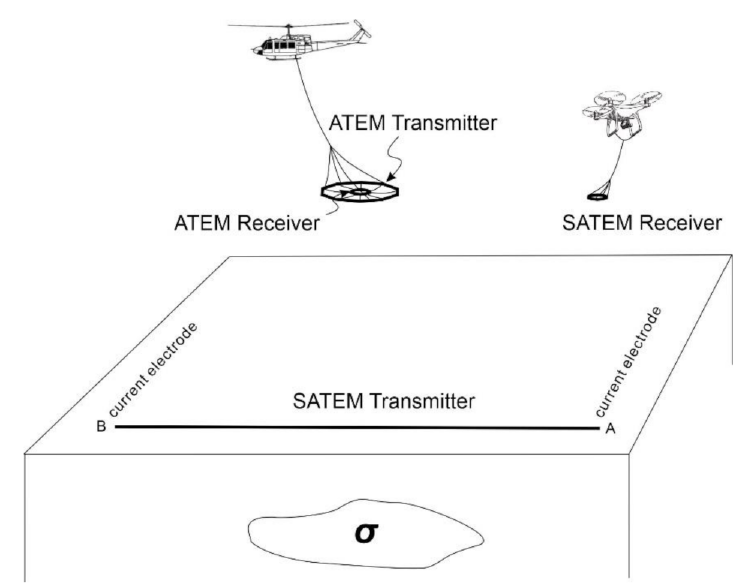
Figure 2. The configuration of ATEM and SATEM systems.